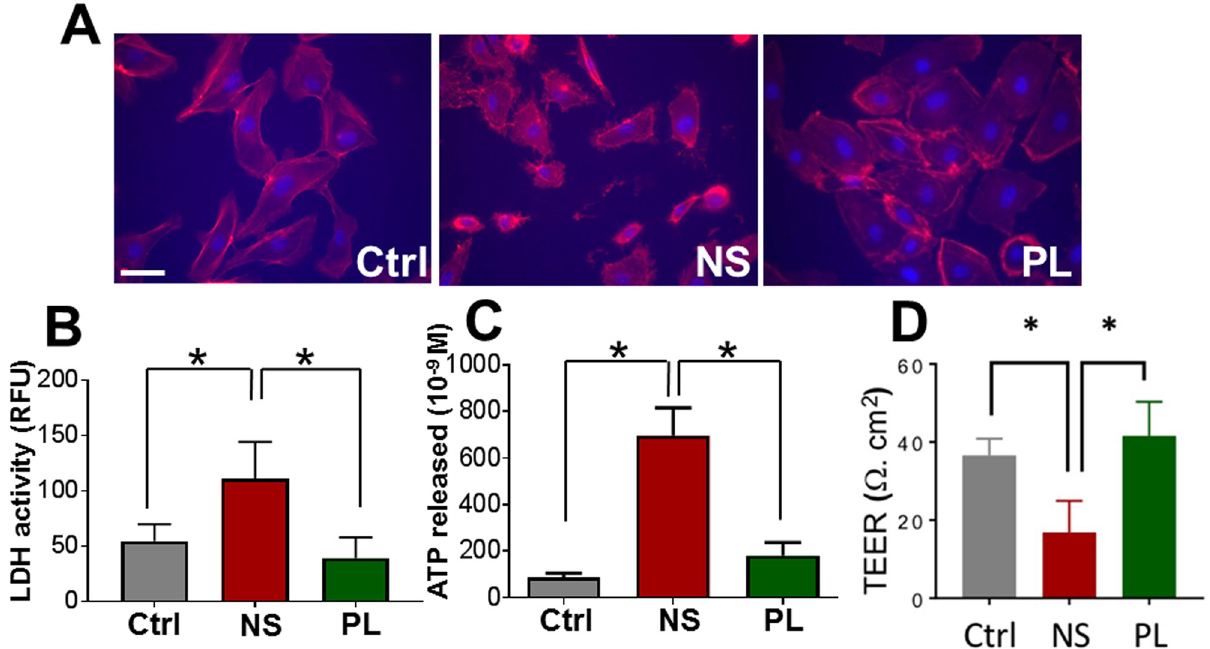
Fig 1. Incubation of human saphenous vein endothelial cells (HSVEC) in Normal Saline but not Plasma-Lyte leads to loss of membrane integrity. HSVEC were incubated in basal medium (Ctrl), Normal Saline (NS) or Plasma-Lyte (PL) for 2 hours, fixed, and stained with phalloidin ( A , red stain; scale bar = 5 μ m). Supernatants were collected and LDH activity ( B ) and ATP levels ( C ) were measured ( � p < 0.05, n = 3–5, where n = the number of cell plates from different passages of cells). Transendothelial electrical resistance (TEER) ( D ) was measured 2 hours after treatment with NS with an epithelial voltohmmeter using STX2 chopstick electrodes ( � p < 0.05, number of cell plates (n) = 6 in triplicates from different passages of cells).